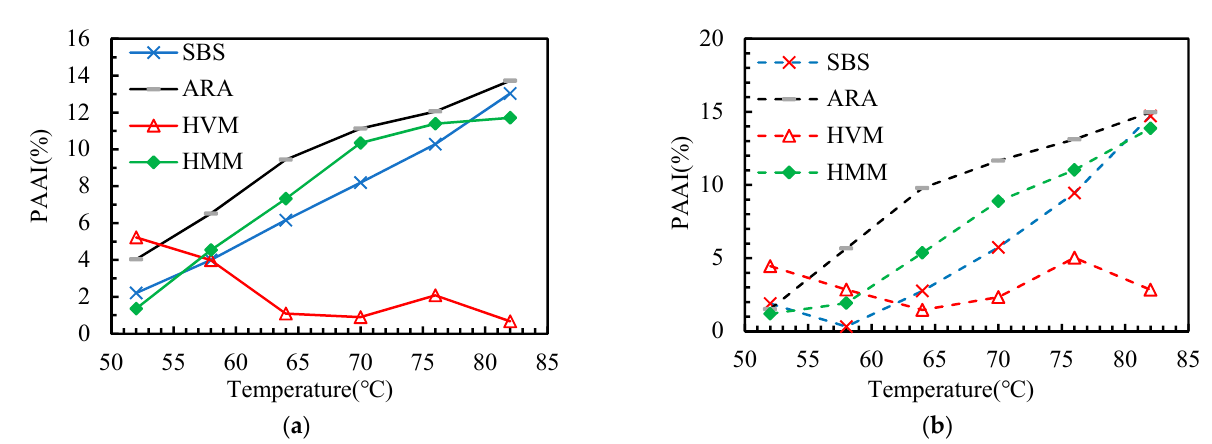
Figure 7. Phase Angle Aging Indicator (PAAI) of the asphalt binders after aging: ( a ) TFOT; ( b ) PAV.